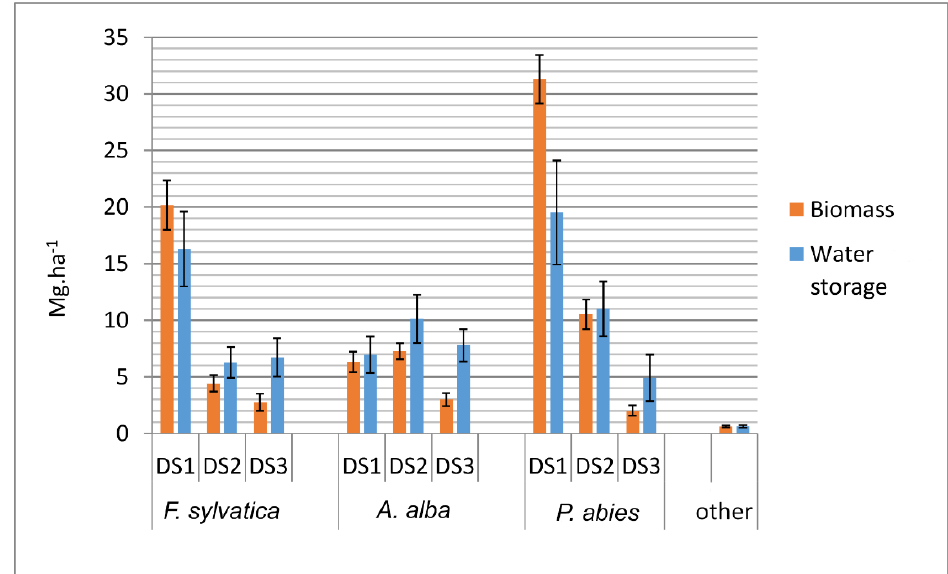
Figure A2. Amounts of biomass and water storage in downed deadwood according to species and decay stage in Zofin. Error bars display confidence intervals.